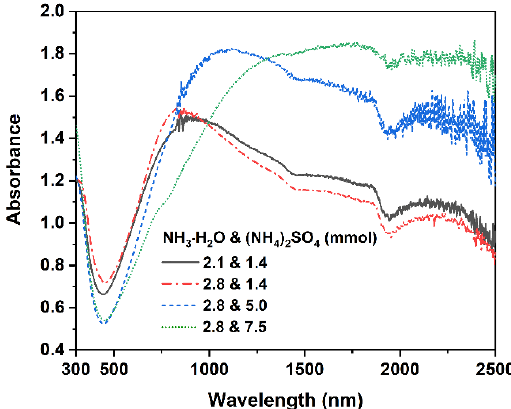
Figure 3. Absorbance spectra of UV–Vis–NIR of Cs 0.3 WO 3 synthesized hydrothermally at 200 °C for 24 h using 0.18 mmol CsCl, 0.4 mmol WO 3 , 8.8 mmol CH 3 CH 2 CHO and NH 3 ·H 2 O and (NH 4 ) 2 SO 4 of